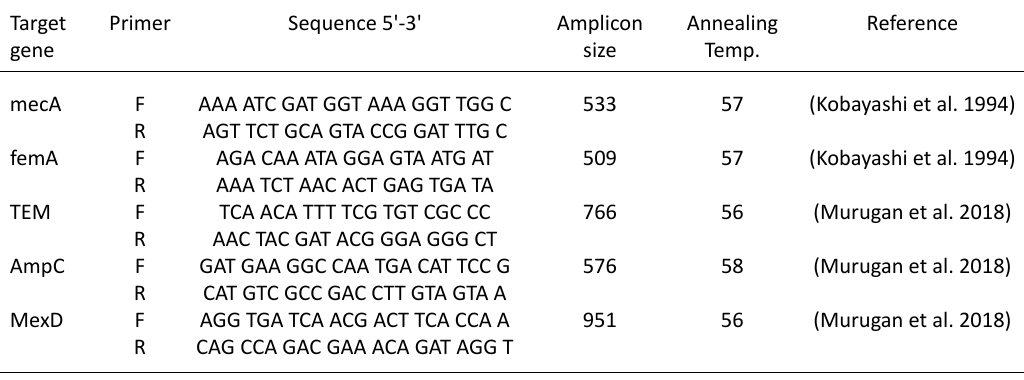
Table 2. list of primers used in the detection of genetic resistance to antibiotics